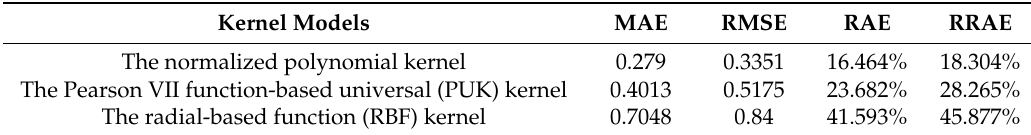
Table 5. Error rates for SVM regression. Kernel Models